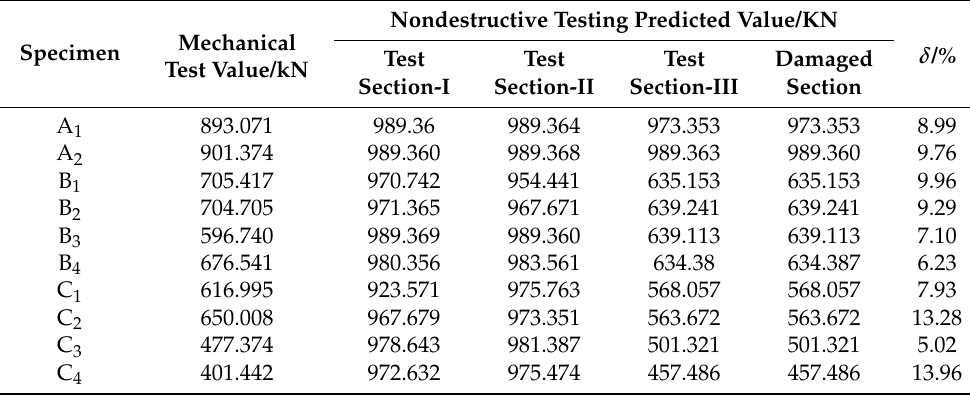
Table 2. Comparison of measured compressive capacity and nondestructive prediction using